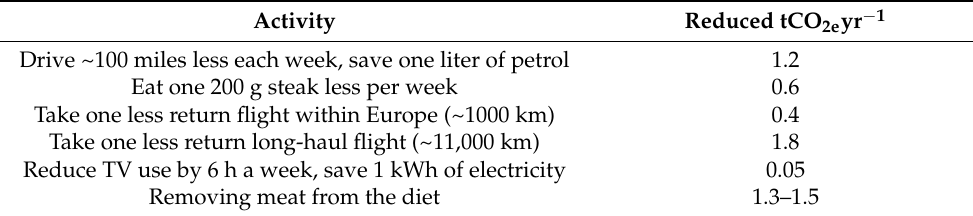
Table 7. Comparison of methods of reducing an individual carbon footprint (per person). The comparative data are calculated from